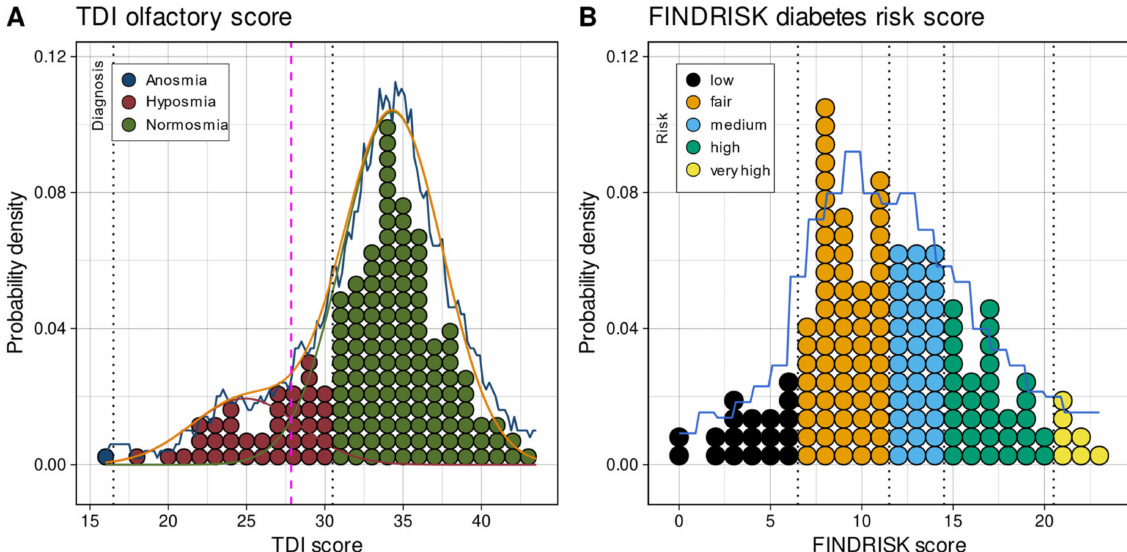
Figure 2. Distribution and group structures of one-dimensional main data: TDI olfactory score and FINDRISK score of diabetic risk. The dotplots show the individual values arranged in bins along with the range of values. The dots are colored according to predefined groups. Group boundaries are shown as vertical dashed black lines. The distribution of the data is shown as probability density function (PDF) estimated by means of the Pareto density estimation (PDE [61]; blue line) and overlaid on the histogram-like dotplots. For the olfactory TDI score, a GMM fit is shown as a red line, and the M = 2 single mixes are indicated as different colored lines. The Bayesian boundary between the Gaussians is indicated as a perpendicular magenta dashed line. The figure has been created using the R software package (version 4.0.5 for Linux; https://CRAN.R-project.org/ [54]) and the library “ggplot2” (https://cran.r-project.org/package=ggplot2 [112]). The colors were selected from the “colorblind_pal” and “stata_pal” palettes provided with the R library “ggthemes” (https://cran.r-project.org/package=ggthemes [113]). Table 2. Basic descriptive statistics of sociodemographic, disease-related, and metabolomics parameters of the participants.